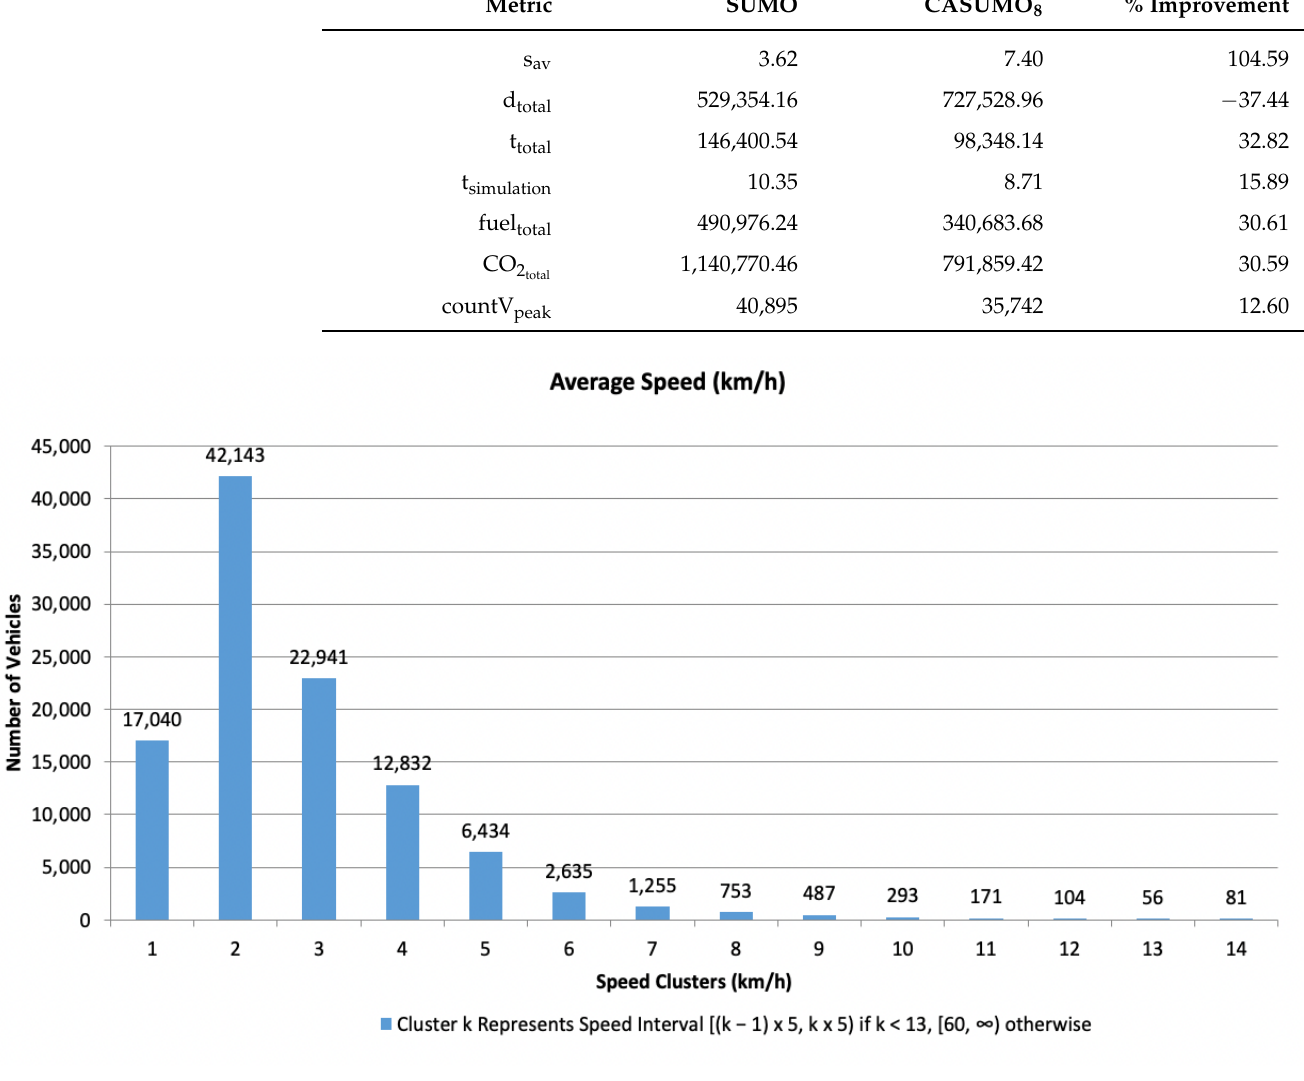
Figure 12. Speed distribution in clusters for 100 K+ simulated vehicles in Tokyo with δ =